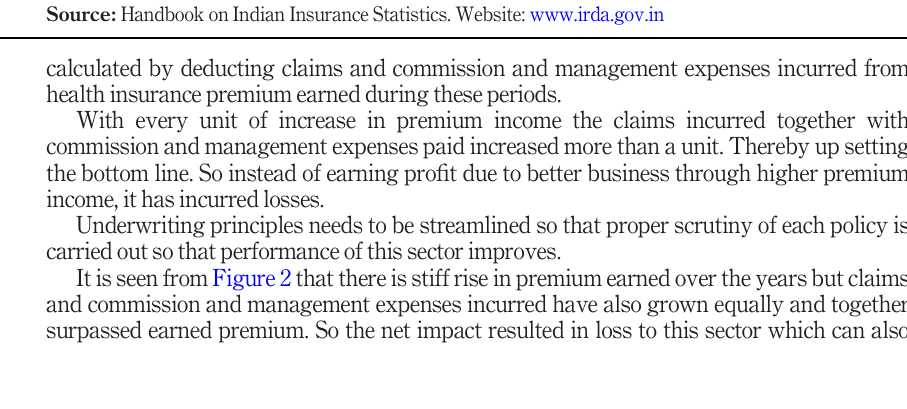
Table 2. Data on